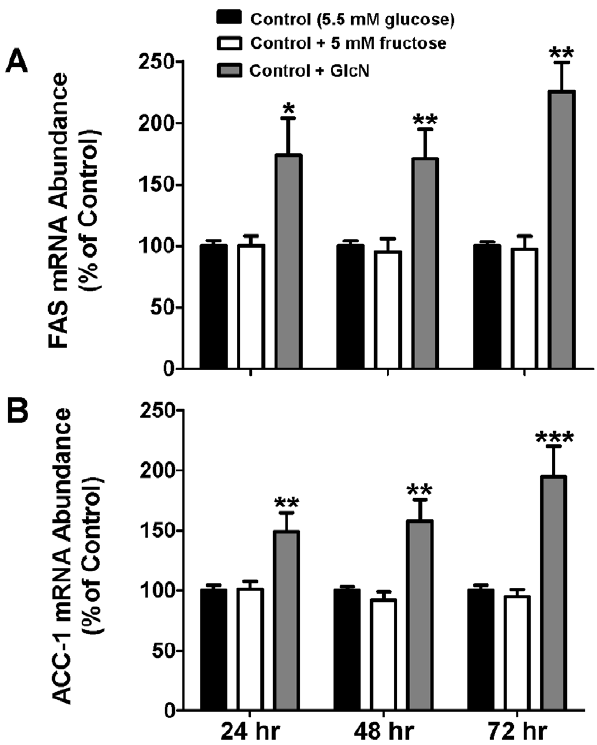
Figure 1. Induction of lipogenic gene expression by glucos- amine (GlcN) treatment but not fructose treatment of HepG2 cells. Transcript abundances of ( A ) FAS (fatty acid synthase) and ( B ) ACC-1 (acetyl-CoA carboxylase) at 24, 48 and 72 h was determined in cells incubated in 5.5 mM glucose (control), glucose + 5 mM fructose, or glucose + GlcN. mRNA abundance is expressed relative to the mean